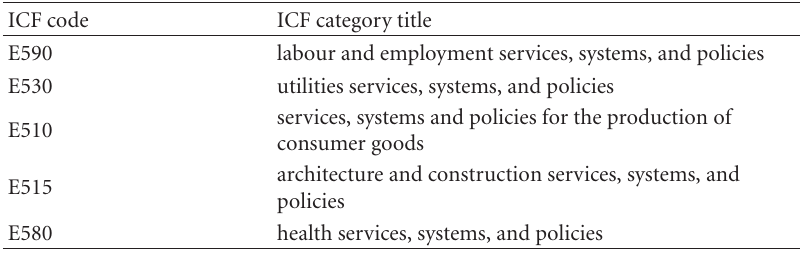
Table 4: Key skills in neurological palliative care and